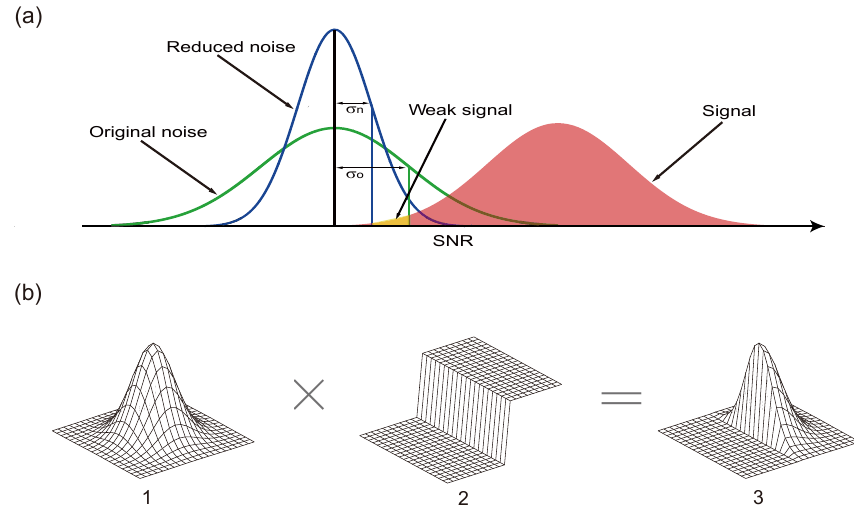
Figure 2. (a) Comparison of original noise, reduced noise and hydrometeor signal distributions. σ o and σ n are 1 standard deviation of the original and reduced background noise, respectively. (b) Illustration of the bilateral filtering process: (b1) Gaussian kernel distribution in space, (b2) δ function and (b3) bilateral kernel by combining Gaussian kernel with δ